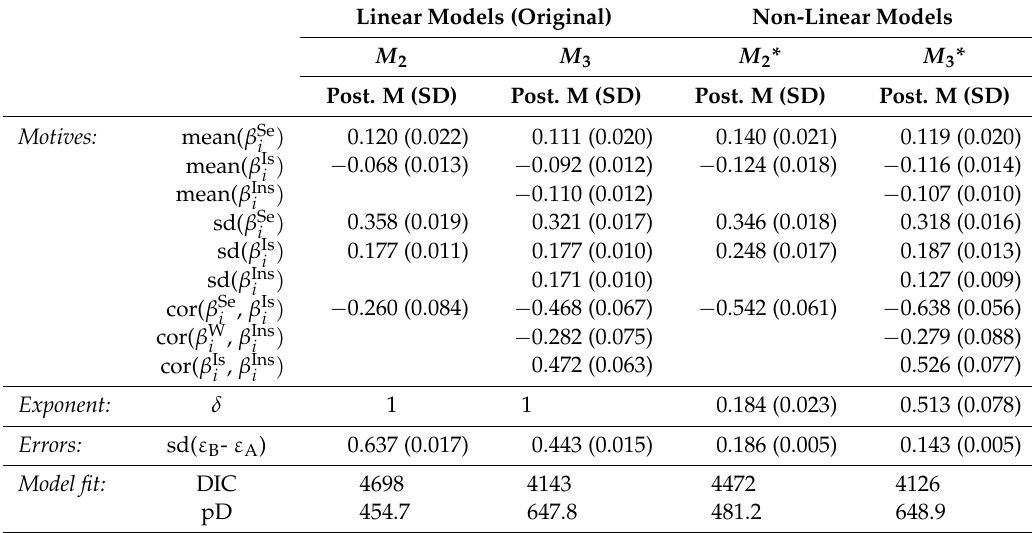
Table 8. Estimated Social Motives for Linear and Nonlinear models Fitted on Experiment